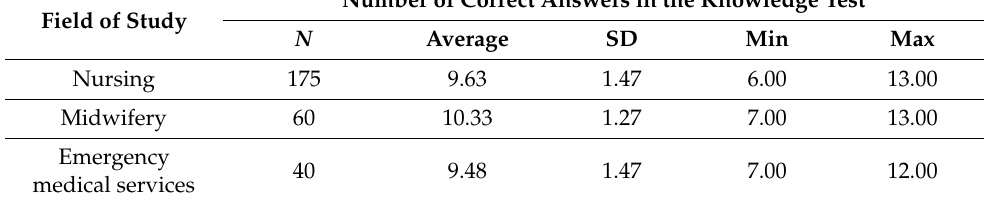
Table 4. Level of knowledge of nursing, midwifery, and emergency medical services students by field of